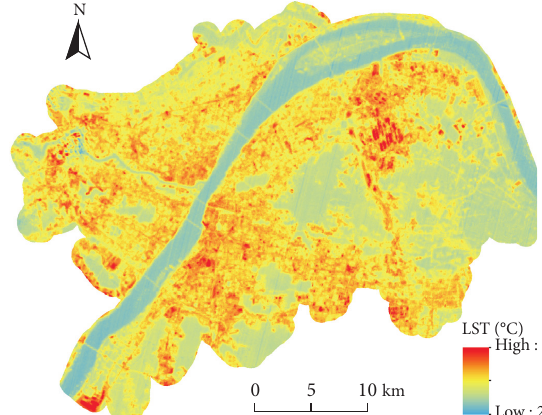
Figure 8: Spatial distribution of LST in